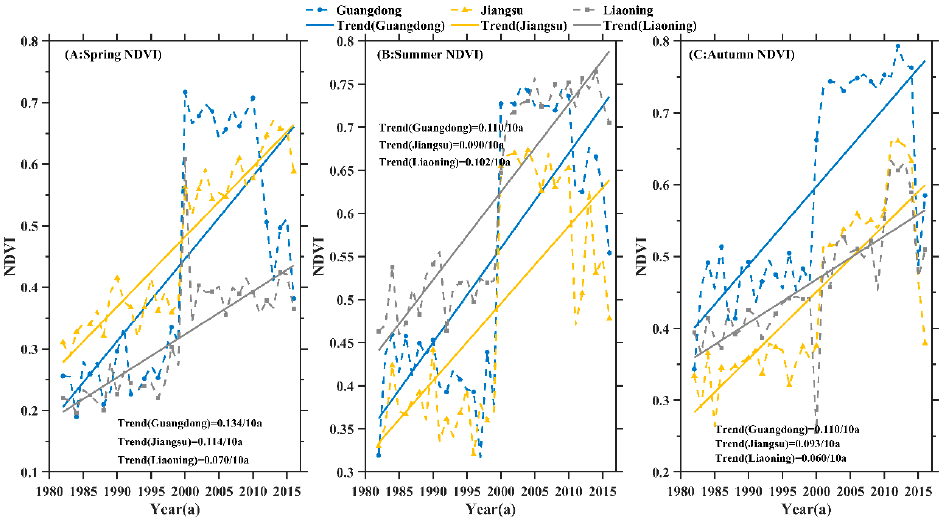
Figure 3. Historical trends of NDVI in spring, summer and autumn in the growing season from 1982 to 2016 in Guangdong, Jiangsu and Liaoning.